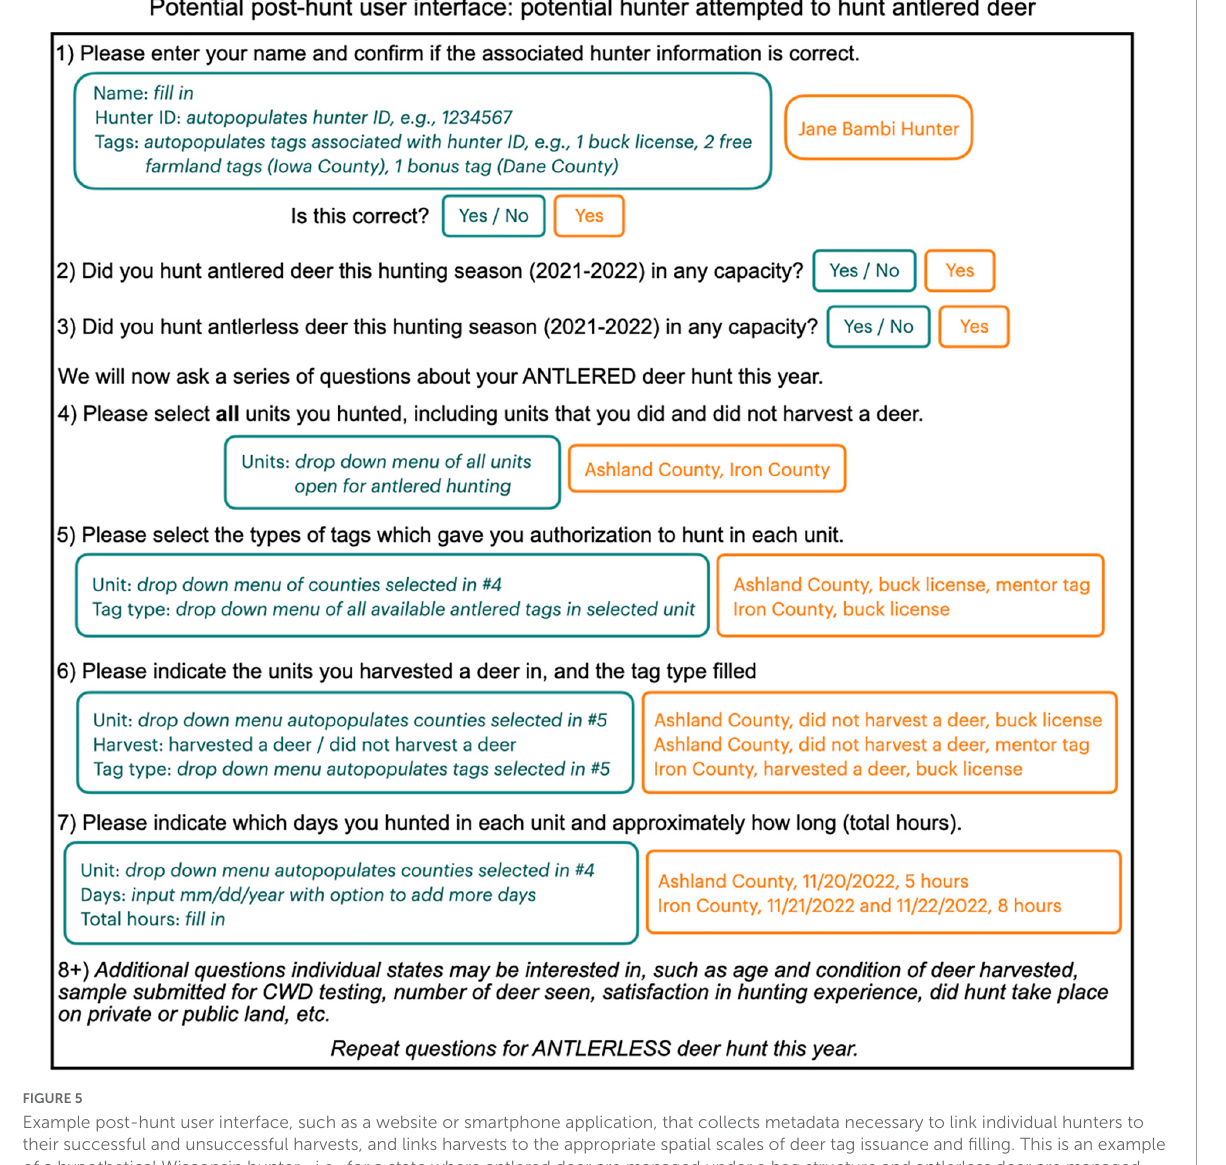
FIGURE5 Example post-hunt user interface, such as a website or smartphone application, that collects metadata necessary to link individual hunters to their successful and unsuccessful harvests, and links harvests to the appropriate spatial scales of deer tag issuance and filling. This is an example of a hypothetical Wisconsin hunter—i.e., for a state where antlered deer are managed under a bag structure and antlerless deer are managed under either a bag structure (free farmland tags) or a quota structure (bonus tags). Black text shows agency designed prompts; teal text shows user interface options where plain text denotes options or titles and italics denotes design choices; orange text shows hypothetical hunter selections or responses. The appearance and order of questions can be dependent on the previous responses such that questions that are not relevant to the hunter or situation do not